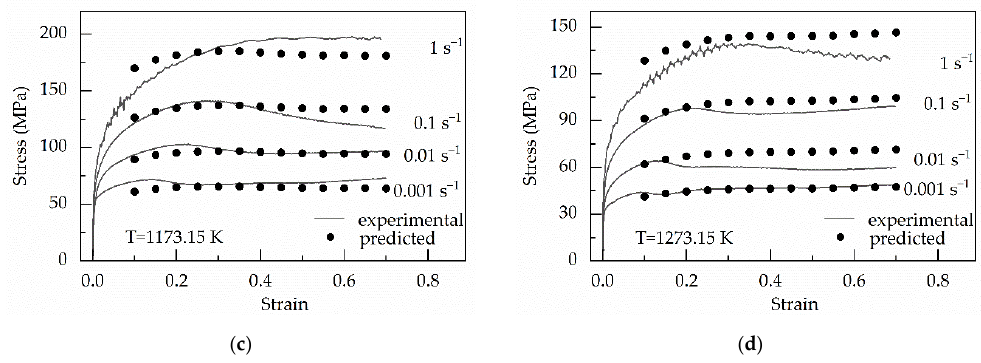
Figure 16. Comparison between the experimental and predicted stress by in the original Hensel–Spittel (oHS) equation at temperatures of ( a ) 973.15 K; ( b ) 1073.15 K; ( c ) 1173.15 K; ( d ) 1273.15 K.